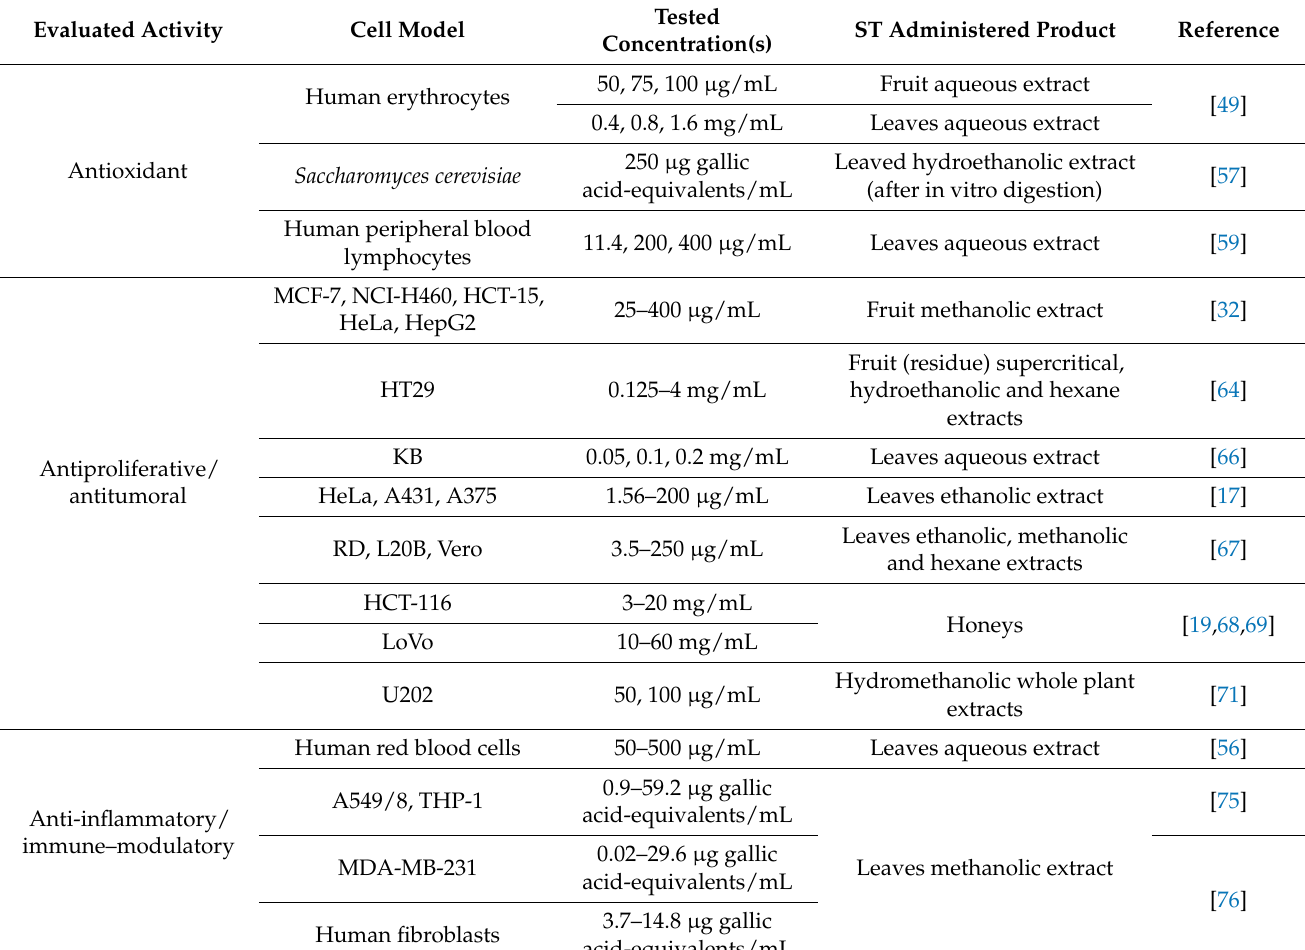
Table 4. Cell models and tested concentrations of ST extracts to evaluate in vitro biological